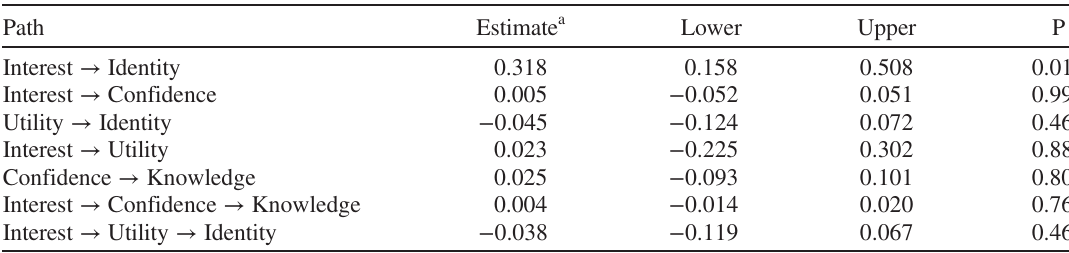
TABLE V. Path differences between girls and boys for the model in Fig. 3.